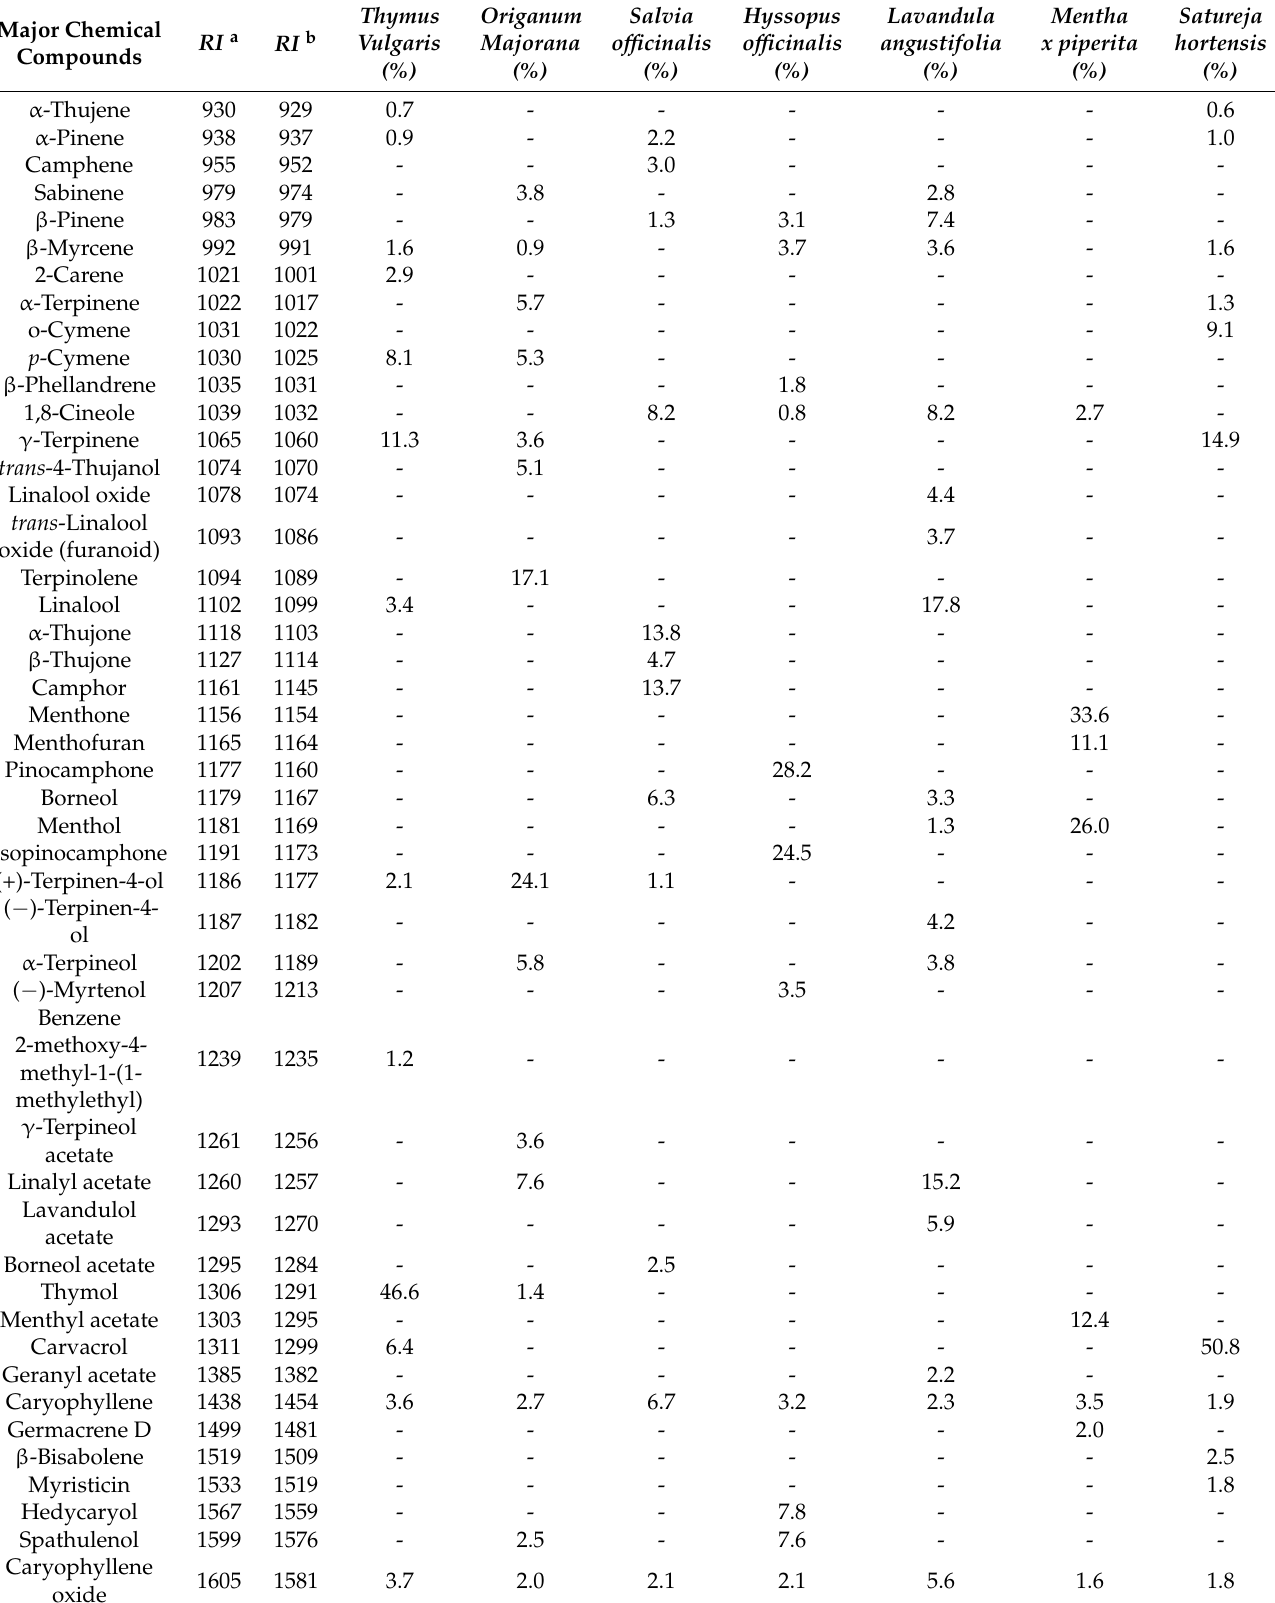
Table 1. Chemical constituents of the essential oils of seven Lamiaceae